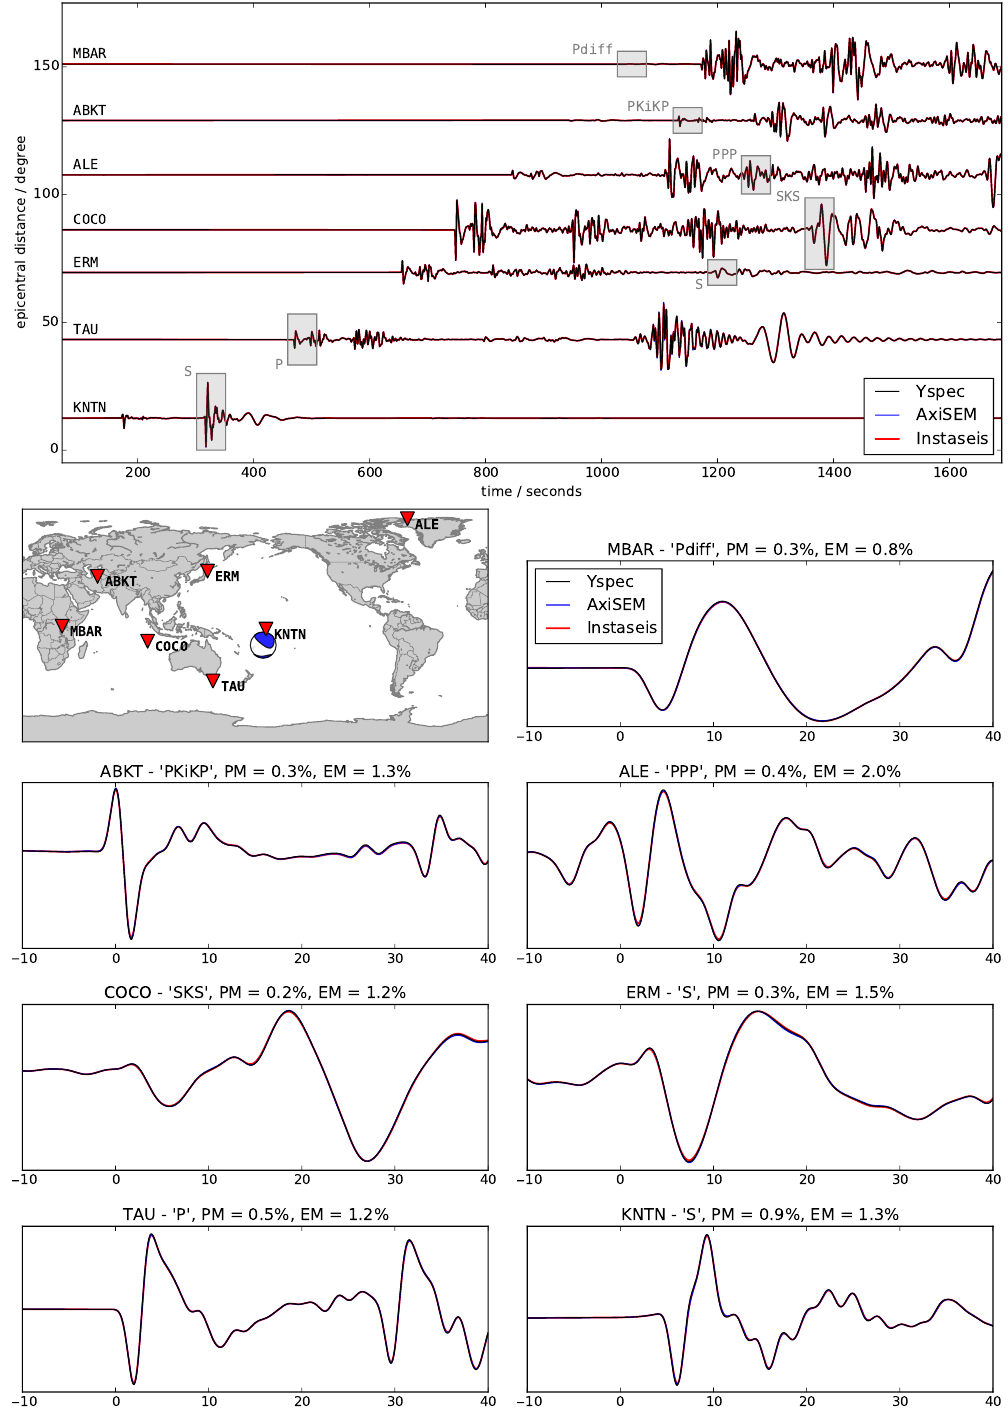
Figure 13. Comparison of vertical displacement seismograms (bandpass filtered from 50 to 2s period) for a moment magnitude M w = 5.0 event in 126km depth under the Tonga Islands, computed with Instaseis, AxiSEM and Yspec in the anisotropic PREM model without ocean but including attenuation. The traces are recorded at the GSN stations indicated in the map. The zoom windows are depicted with gray rectangles in the record section and the time scale is relative to the ray-theoretical arrival. EM and PM (Kristekova et al., 2009) denote the envelope and phase misfit between Instaseis and Yspec traces in the corresponding time